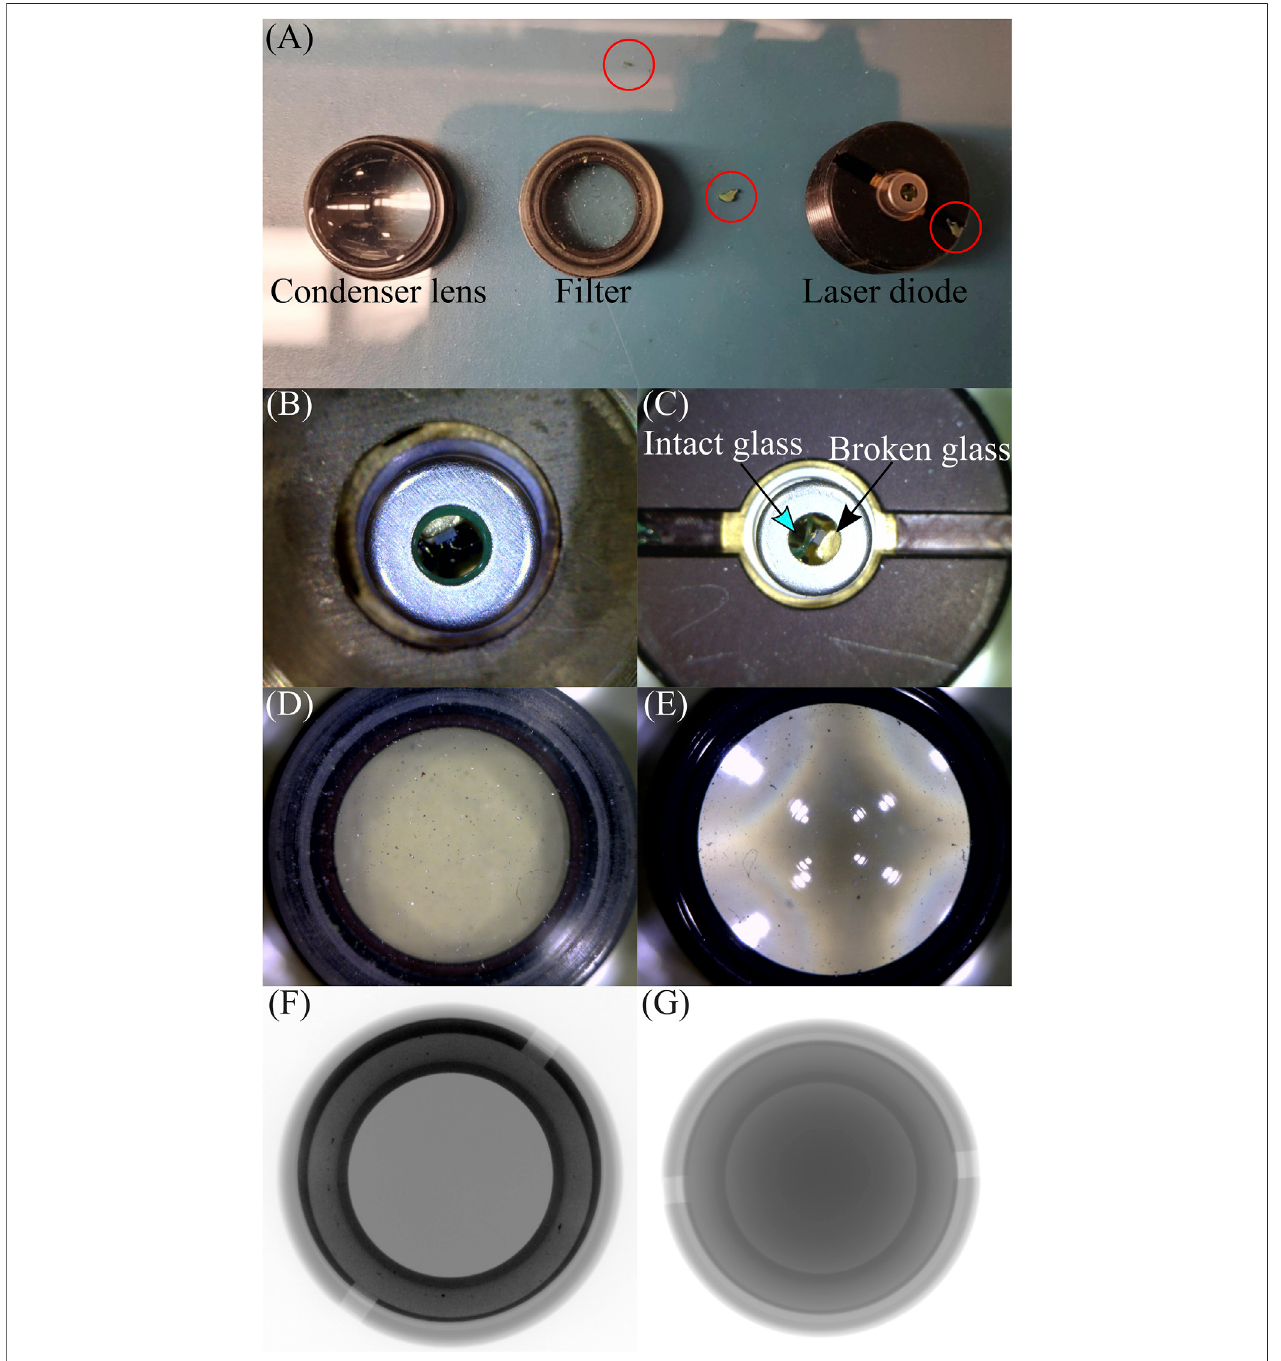
FIGURE10| Impact-testedlenstubecomponentsfromTestarticle#3. (A) Disassembledlenstubecomponents.Brokenshardsofopticalwindowglassofthelaser diodearecircledinred. (B) Microscopeimageofthenewlaserdiode. (C) Microscopeimageoftheimpact-testedlaserdiode. (D) Impact-testedoptical fi lter. (E) Impact- tested condenser lens. Minor internal thread damage due to impact is evident from the aluminum dust specks. (F) X-ray images of the fi lter showing no fractures. (G) X- ray images of the condenser lens show no fractures.